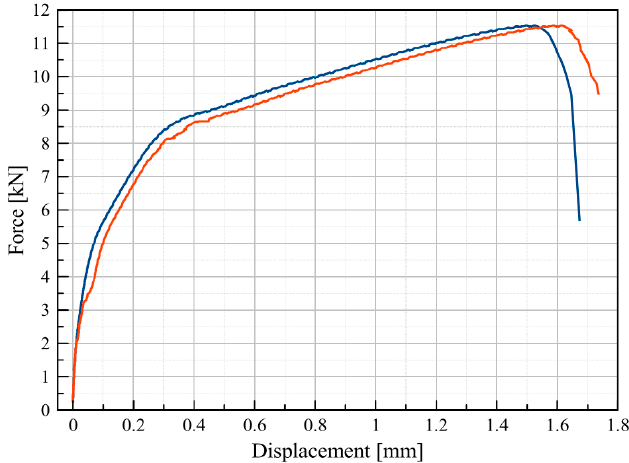
Figure 12. Tensile strength test results.